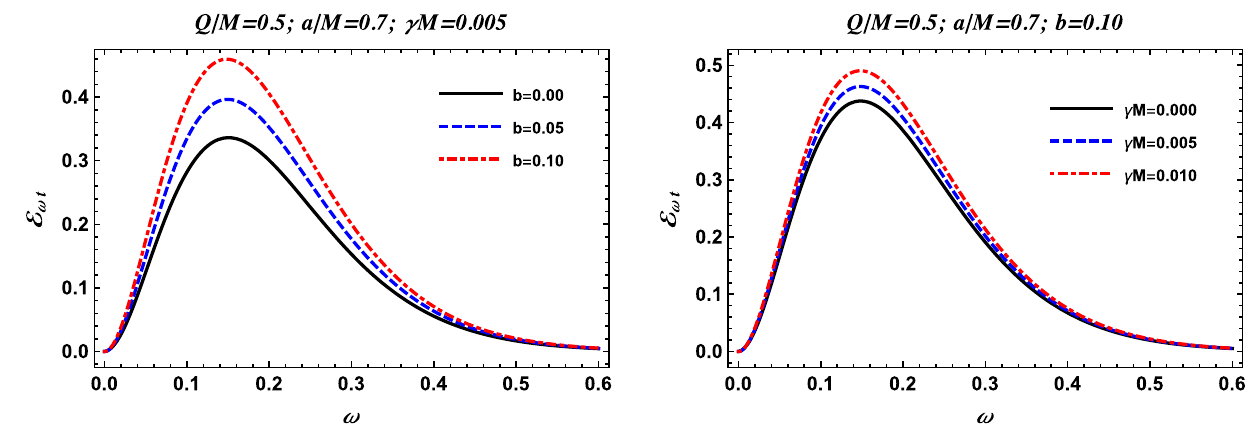
Fig. 6 Plots show the dependence of the emission energy on the different spacetime